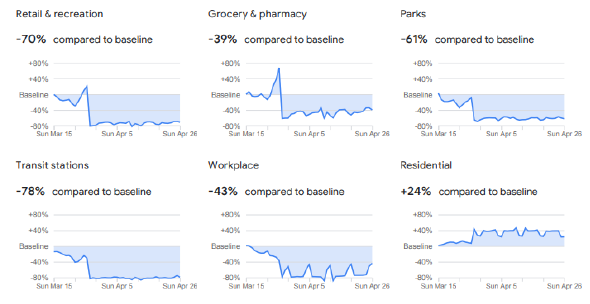
Figure 2: Community